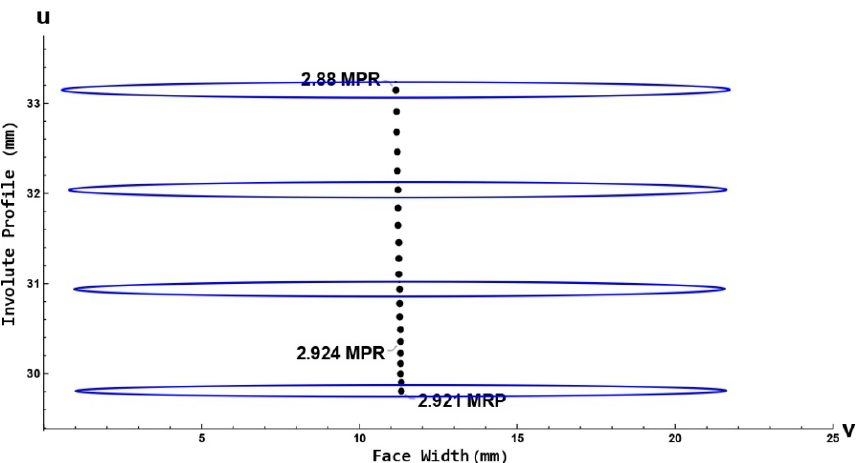
Figure 15. The MPR of crowned spur gears with a minimum amount of circular modification along the path of contact for an out-of-plane misalignment of 0.01° (0.17 mrad), where the blue outlines demonstrate the location of the contact ellipse at the contact point.